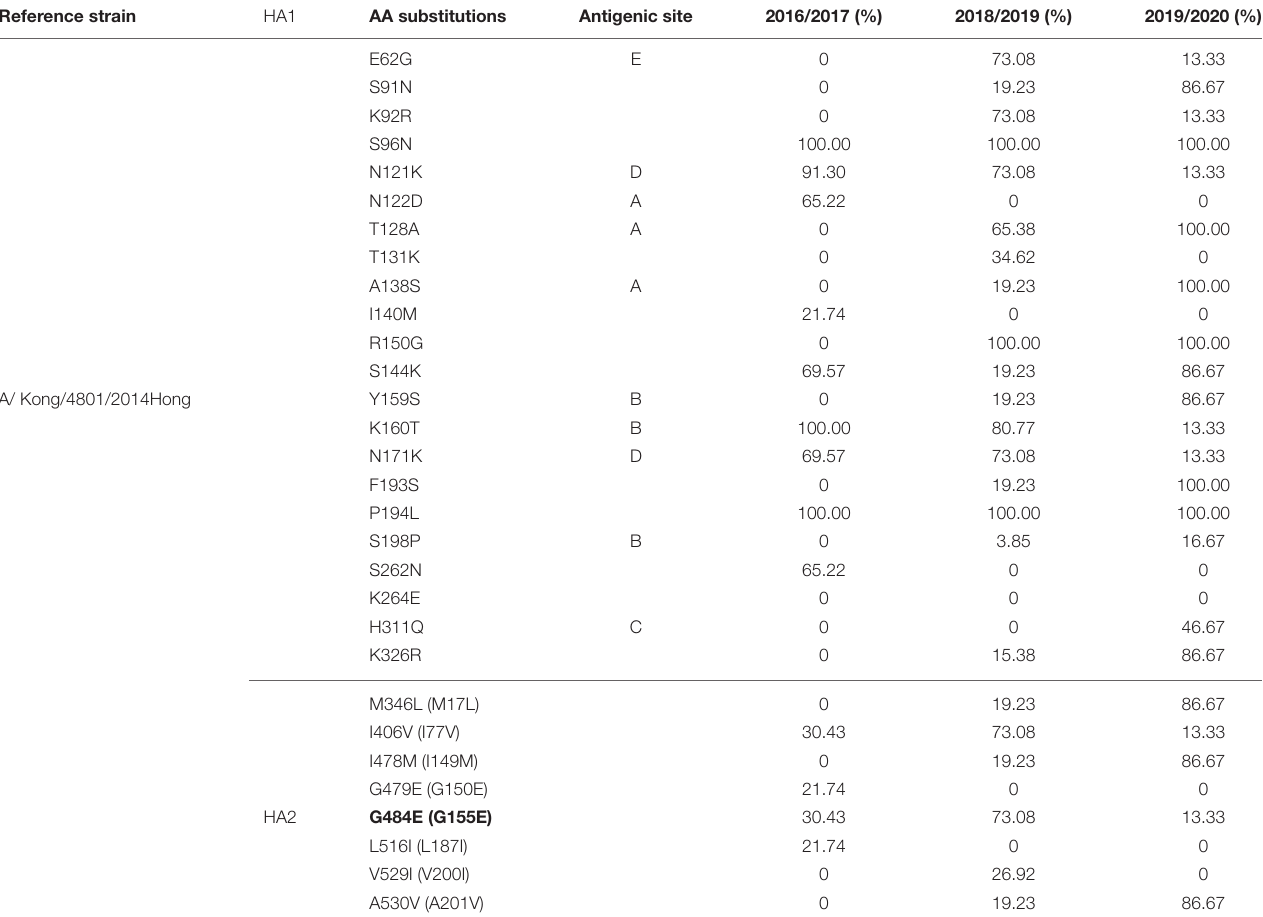
TABLE 5 | Amino acid substitutions identified in HAs of H3N2 viruses sequenced from 2016 to 2020. Reference